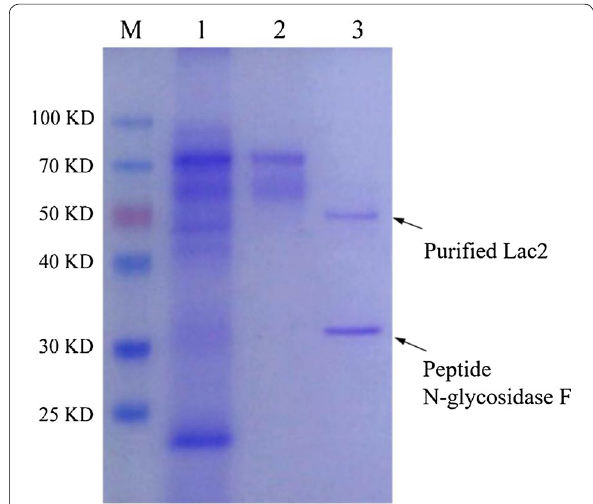
Fig. 3 SDS-PAGE analysis of purified Lac2. Lac2 was purified from the fermentation broth of C. unicolor CGMCC 5.1011. Lane M, protein marker. Lane 1, fermentation broth of C. unicolor CGMCC 5.1011 . Lane 2, purified Lac2. Lane 3, deglycosylated Lac2